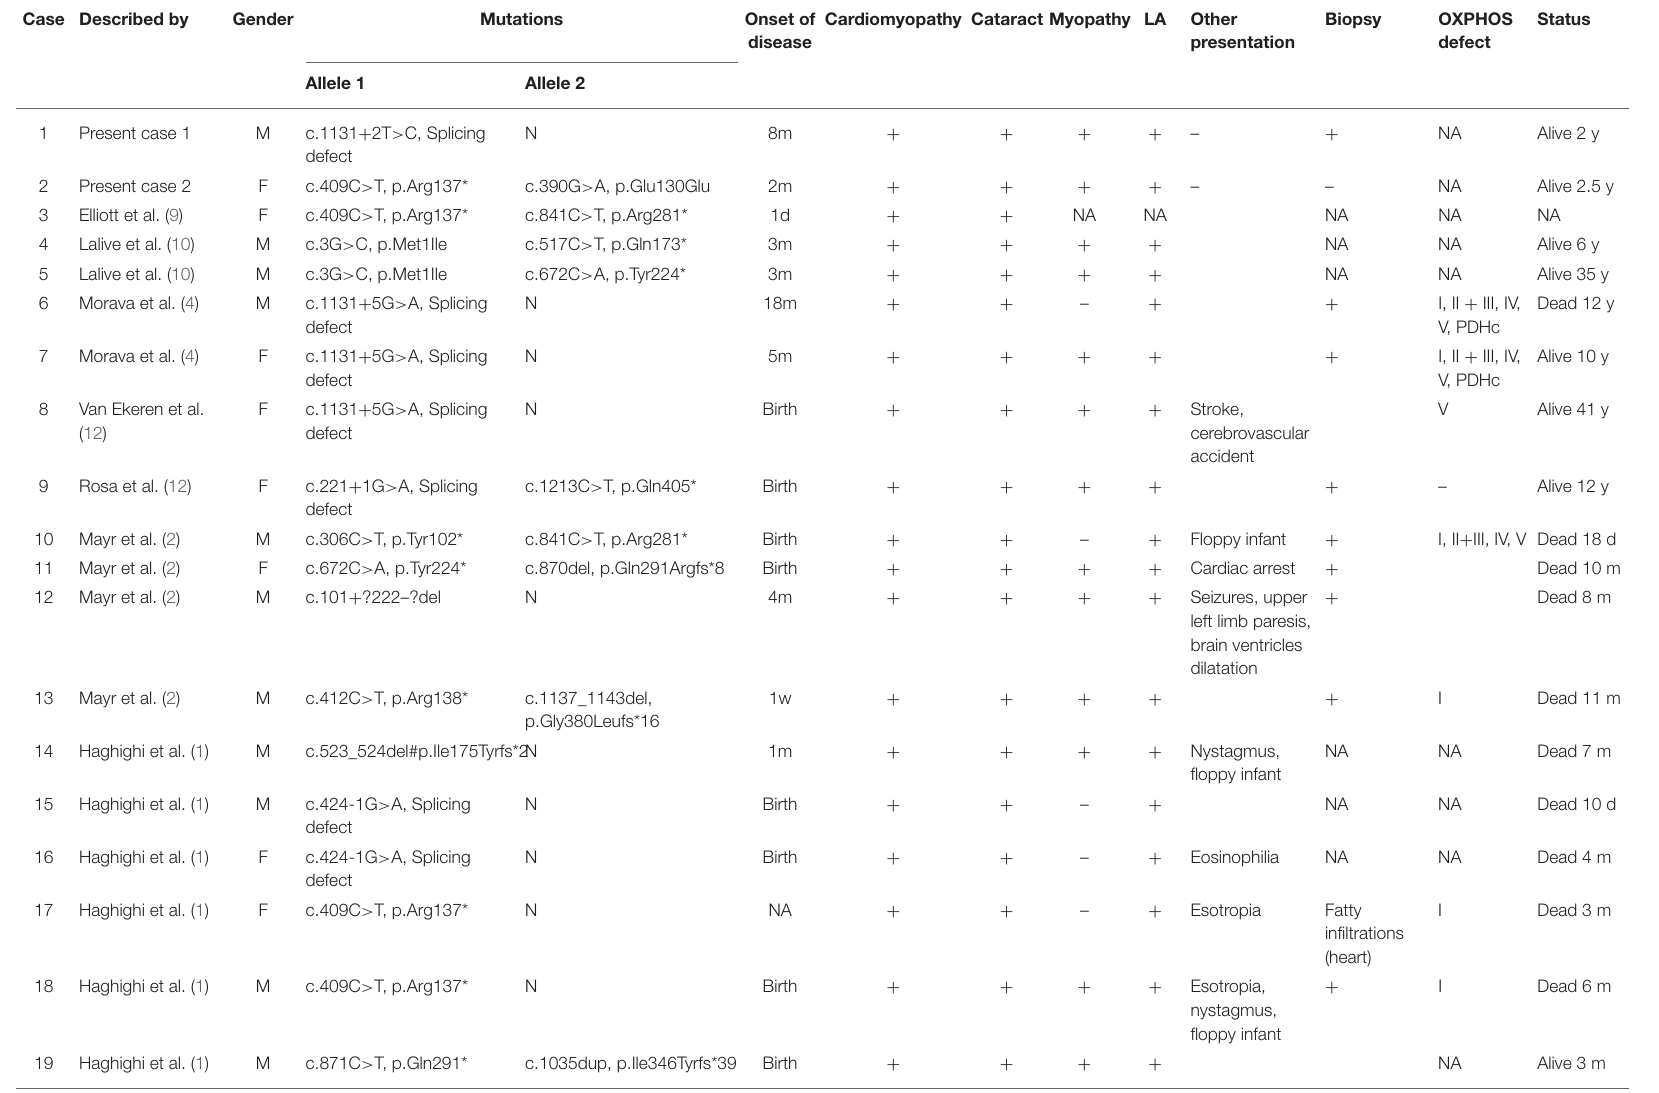
TABLE 1 | Clinical and molecular findings in patients with Sengers-syndrome caused by AGK mutations. Case Described